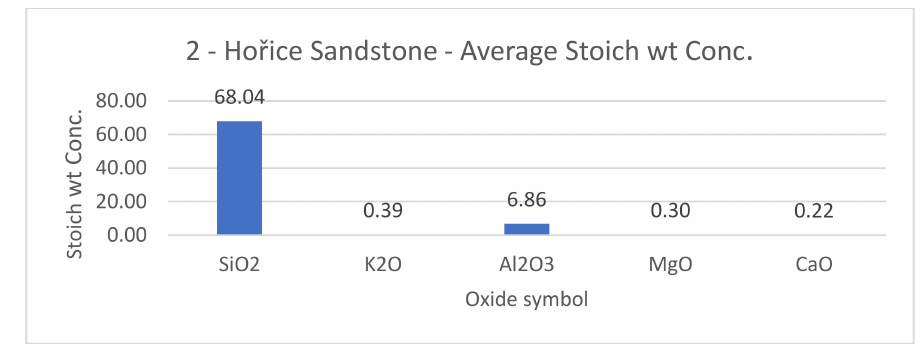
Figure 14. Hoˇrice sandstone average stoichiometric wt concentration.